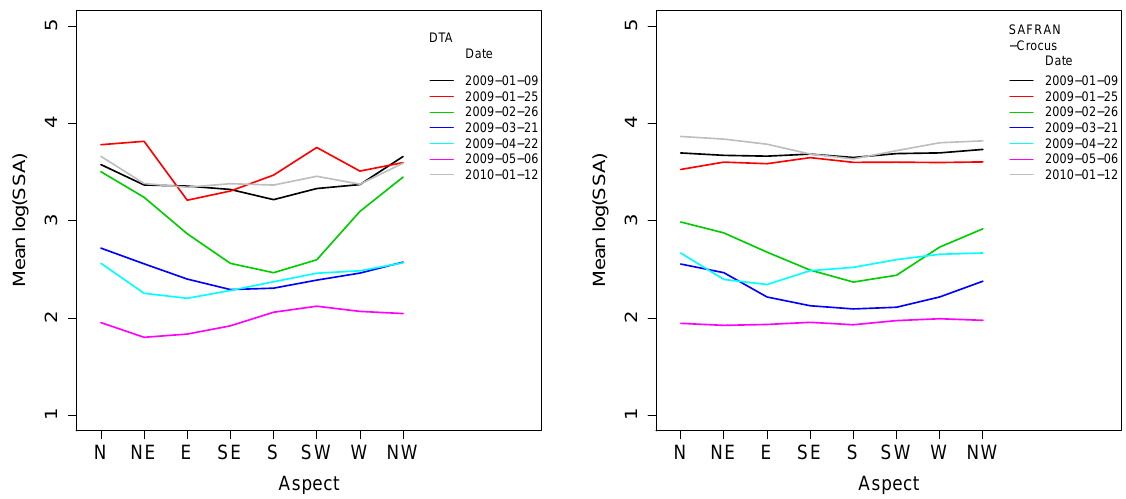
Fig. 12. Mean log(SSA) with regards to aspect, for the six studied dates. DTA (left), and SAFRAN-Crocus (right).